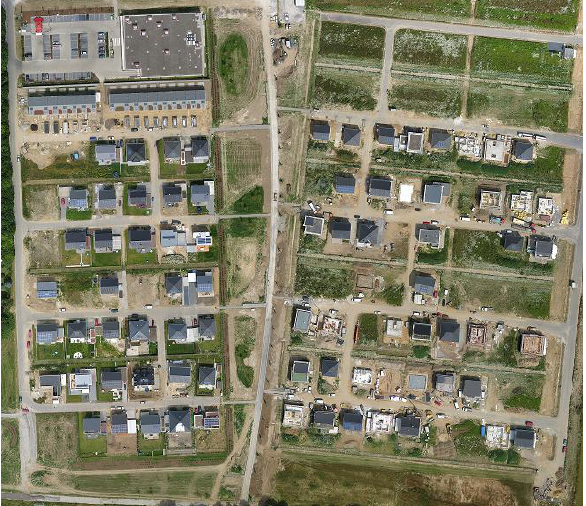
Figure 1: Orthophoto of the zero:e-park acquired in the monitoring campaign (processed by